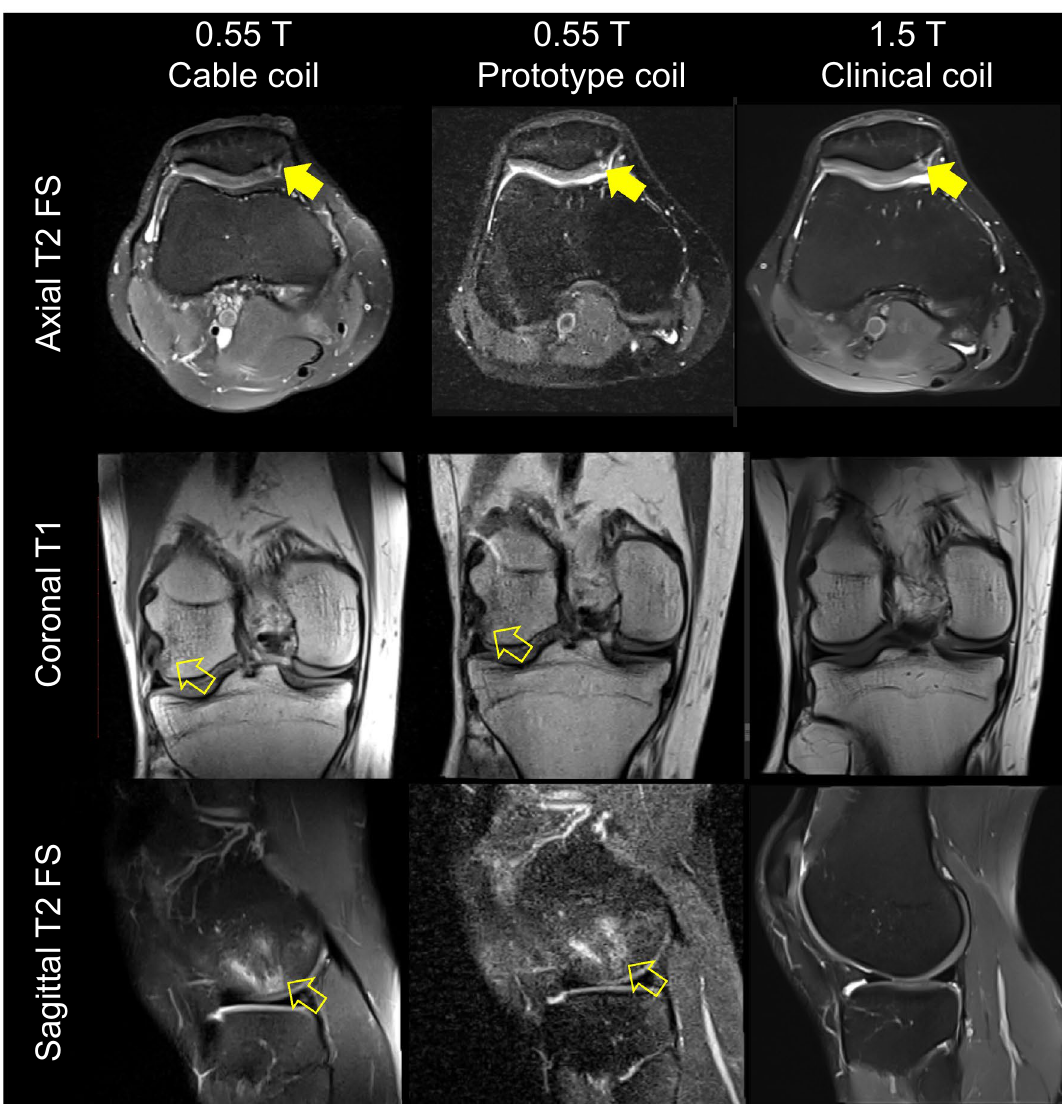
Figure 14. Turbo spin echo MR images of a 34-year-old man acquired using the 0.55 T cable coil (left column), 0.55 T prototype coil (middle column) and 1.5 T clinical coil (right column). The images reveal patellar cartilage defects (solid arrows) and a lateral femoral condyle bone contusion (open arrows). The bone contusion was not present at the time of the 1.5 T